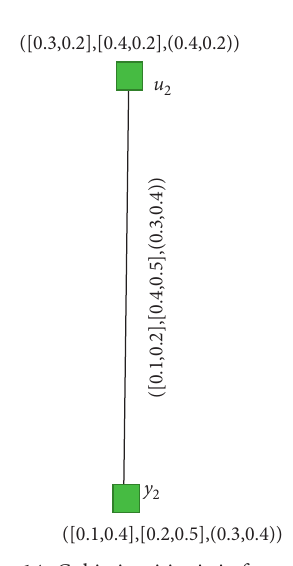
Figure 14: Cubic intuitionistic fuzzy